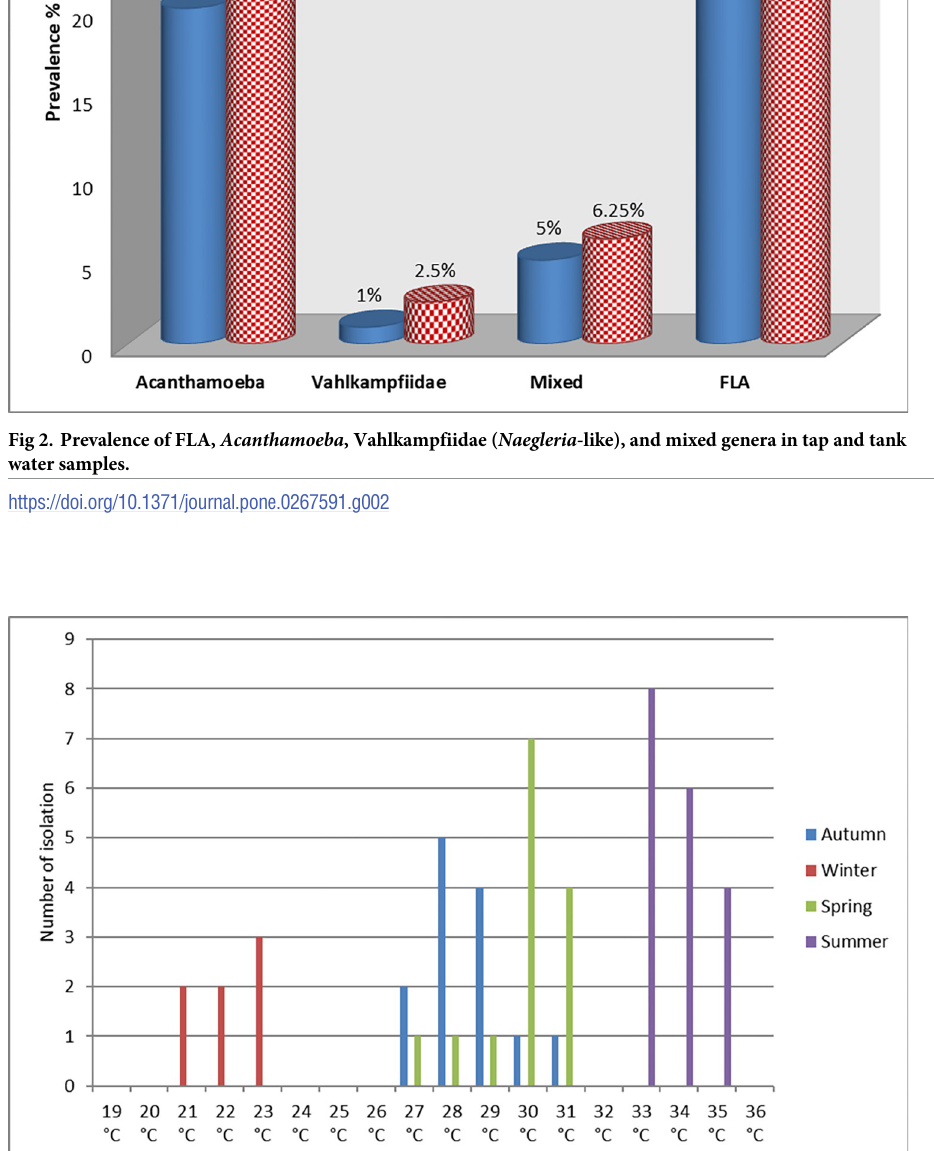
PLOS ONE | https://doi.org/10.1371/journal.pone.0267591 July 8,